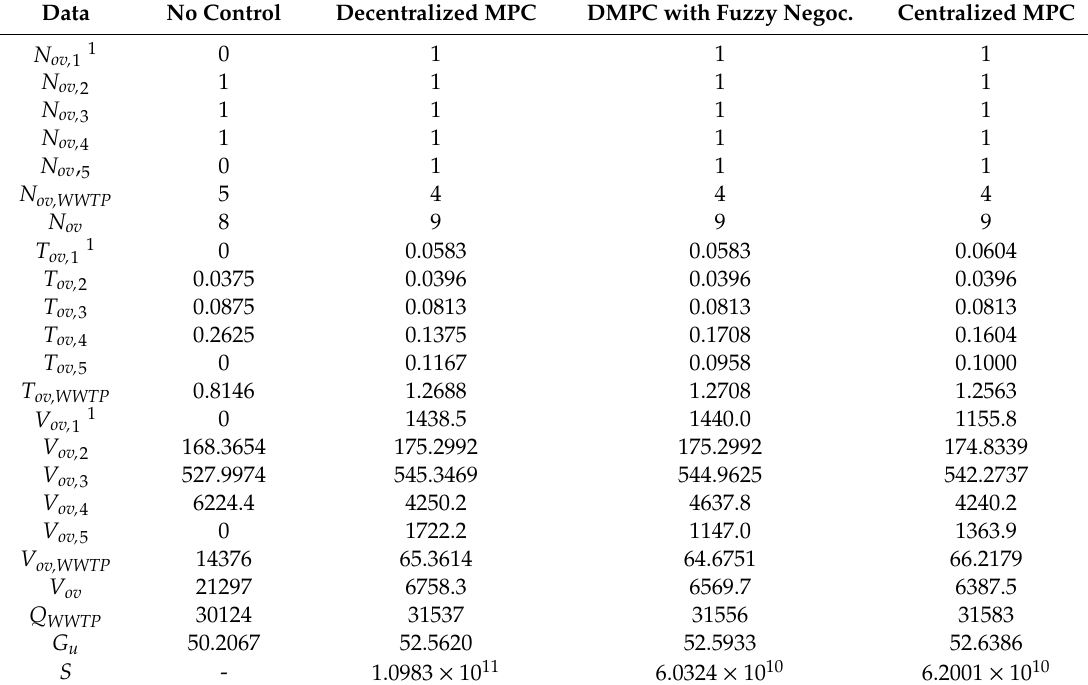
Table 5. Numeric results for scenario